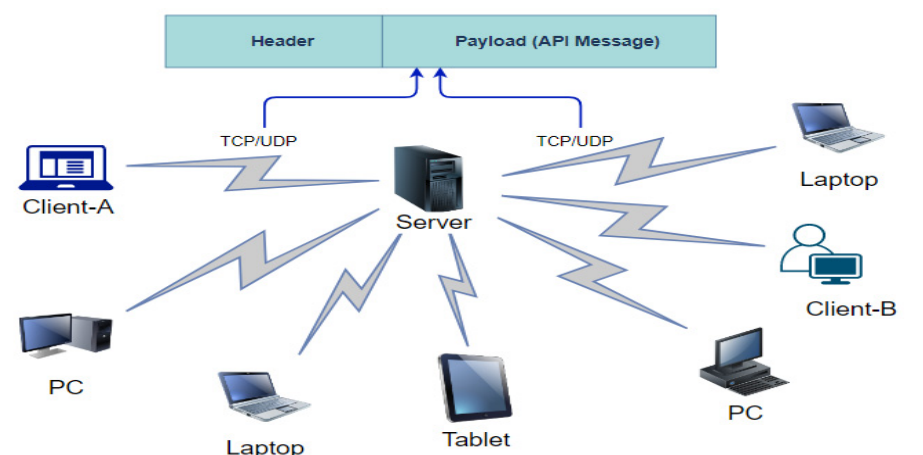
Figure 1. Targeting System Architecture.